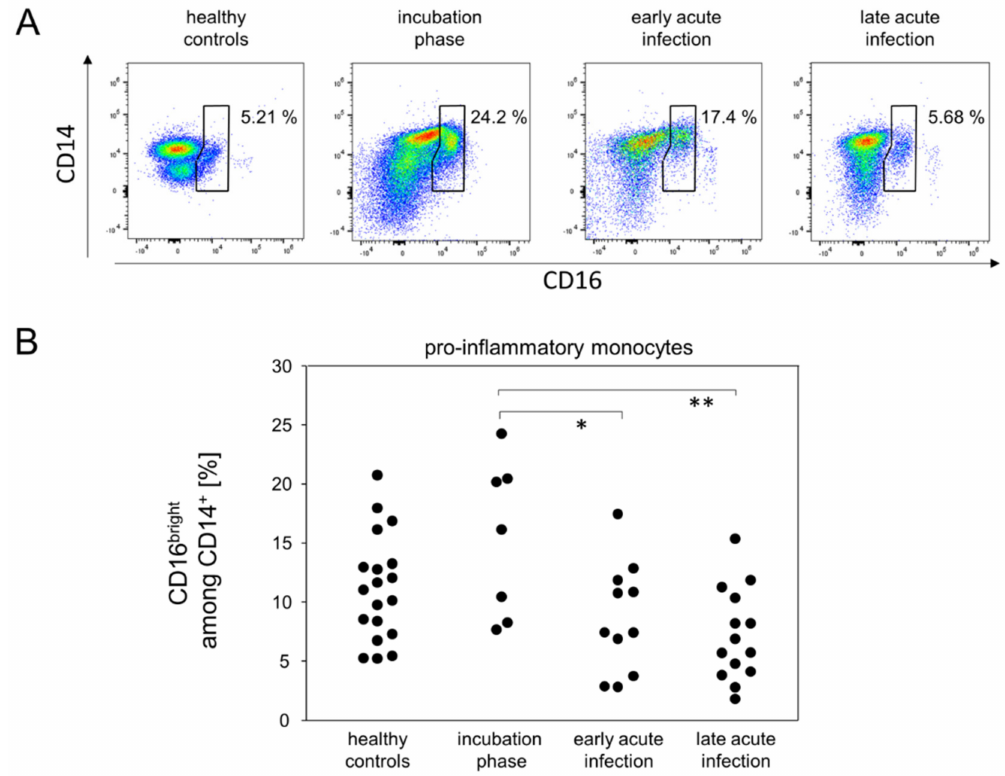
Figure 3. Pro-inflammatory monocytes were more abundant during the incubation phase. ( A )